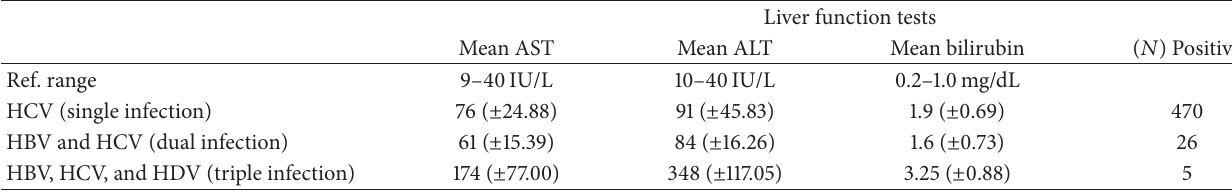
Table 2: Comparison of liver function test results among HBV, HCV, and HDV positive cases.